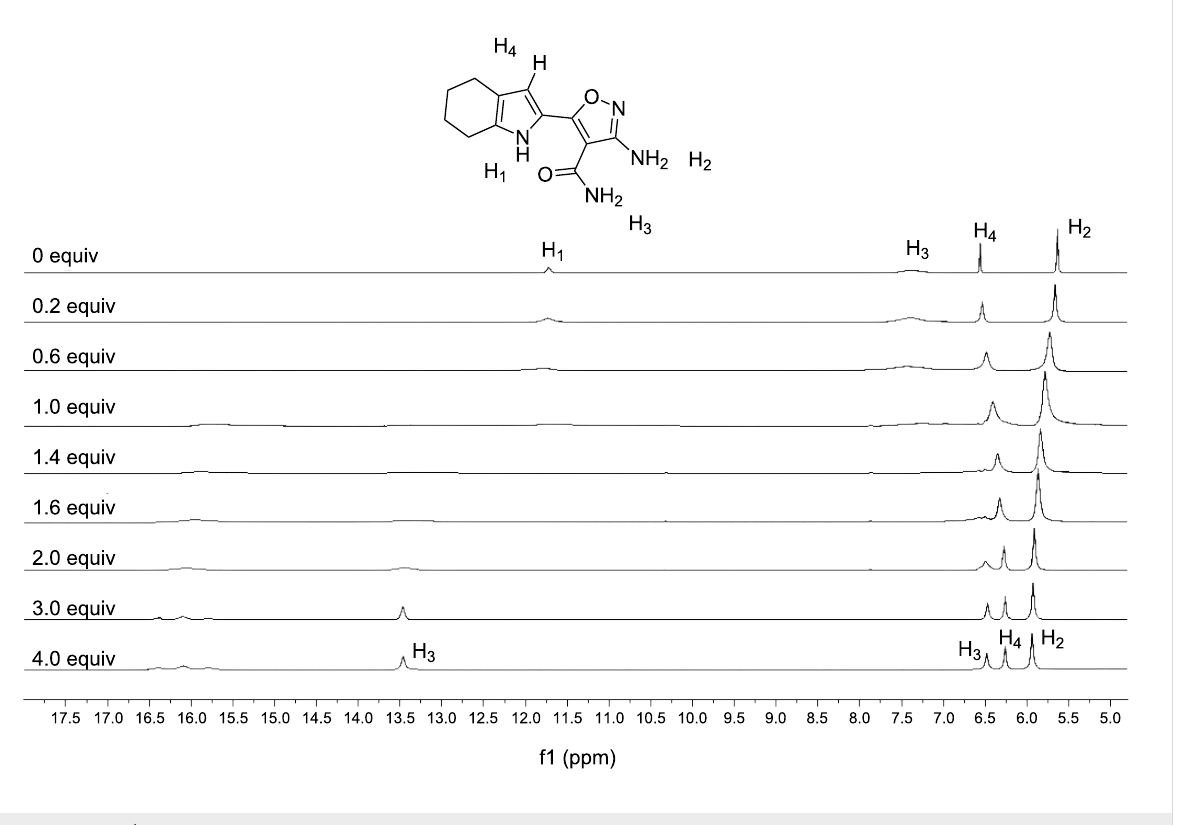
Figure 9: Partial 1 H NMR (400 MHz) spectra of receptor 1 in the presence of 0, 0.2, 0.6, 1.0, 1.4, 1.6, 2.0, 3.0 and 4.0 equiv of TBAF in DMSO- d 6 .